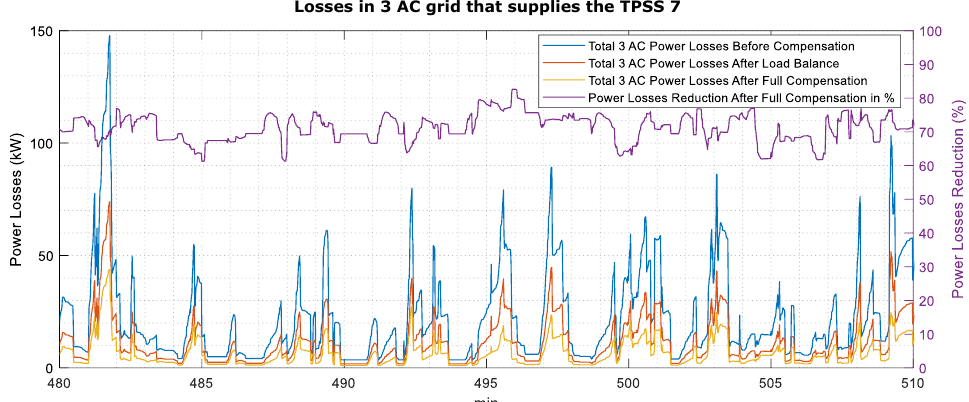
Figure 12. Power losses in the three-phase grid supplying substation #7 with different compensation options.